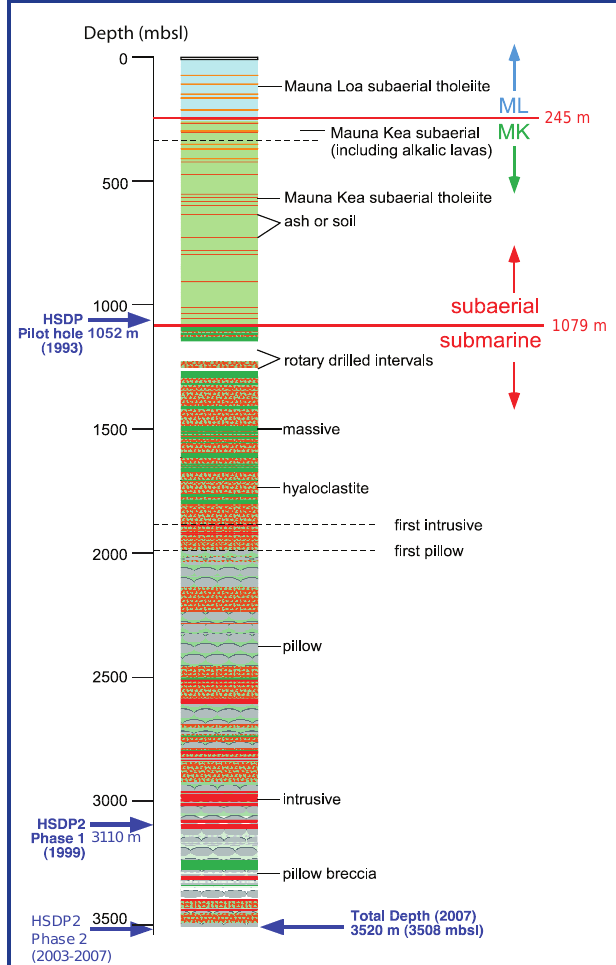
Figure 3. Lithologic column of the HSDP2 drill cores. Boundary between Mauna Loa (ML) and Mauna Kea (MK) lavas is shown, as well as the subaerial-submarine transition, and depths at which the first pillow lava and the first intrusive rocks were encountered. Patterns represent different lithologies as indicated. The total depth of the hole is measured from a reference level 11.7 meters above sea level; the depth scale used here is in meters below sea level